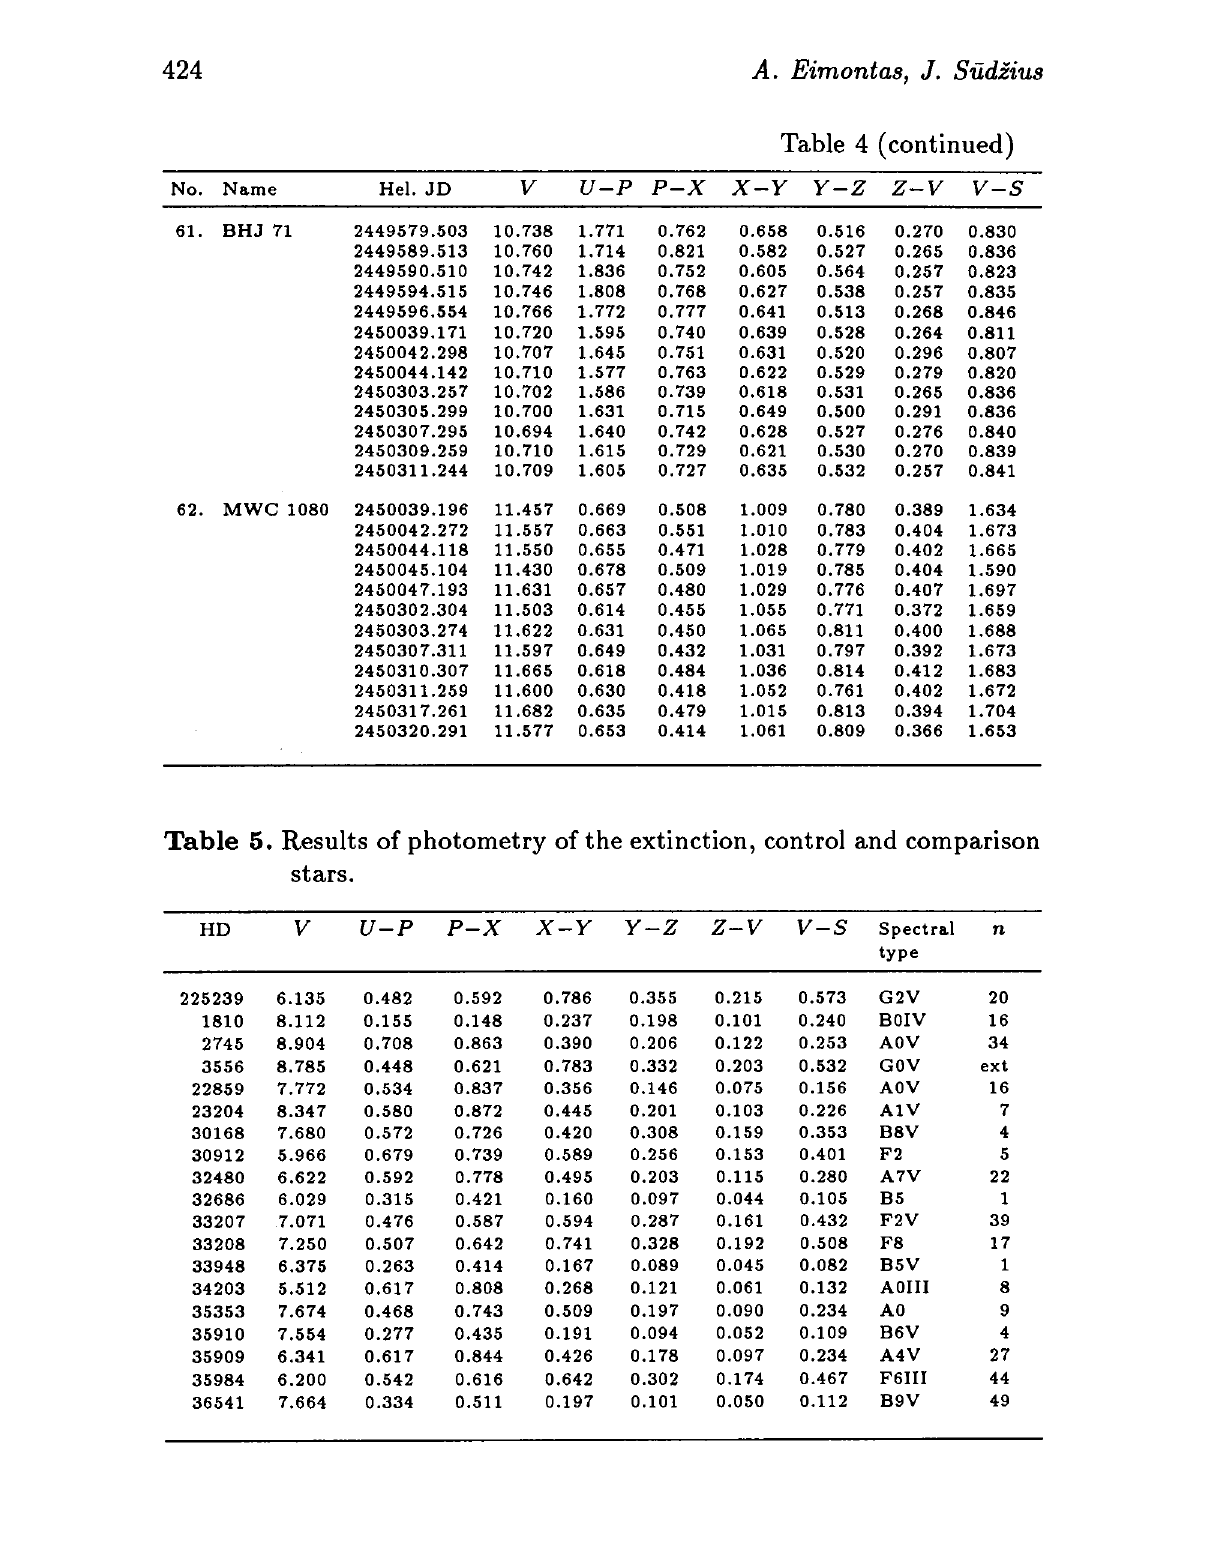
Table 5. Results of photometry of the extinction, control and comparison